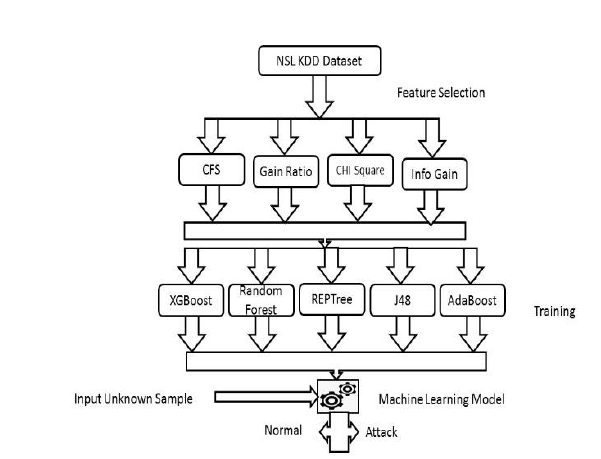
Figure 1. Framework of our proposed NIDS System